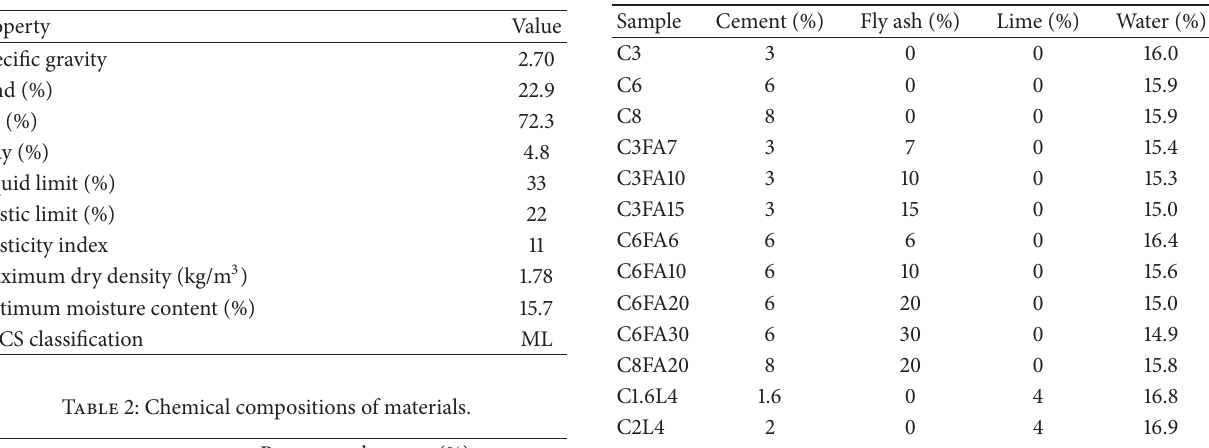
Table 1: Soil index properties.